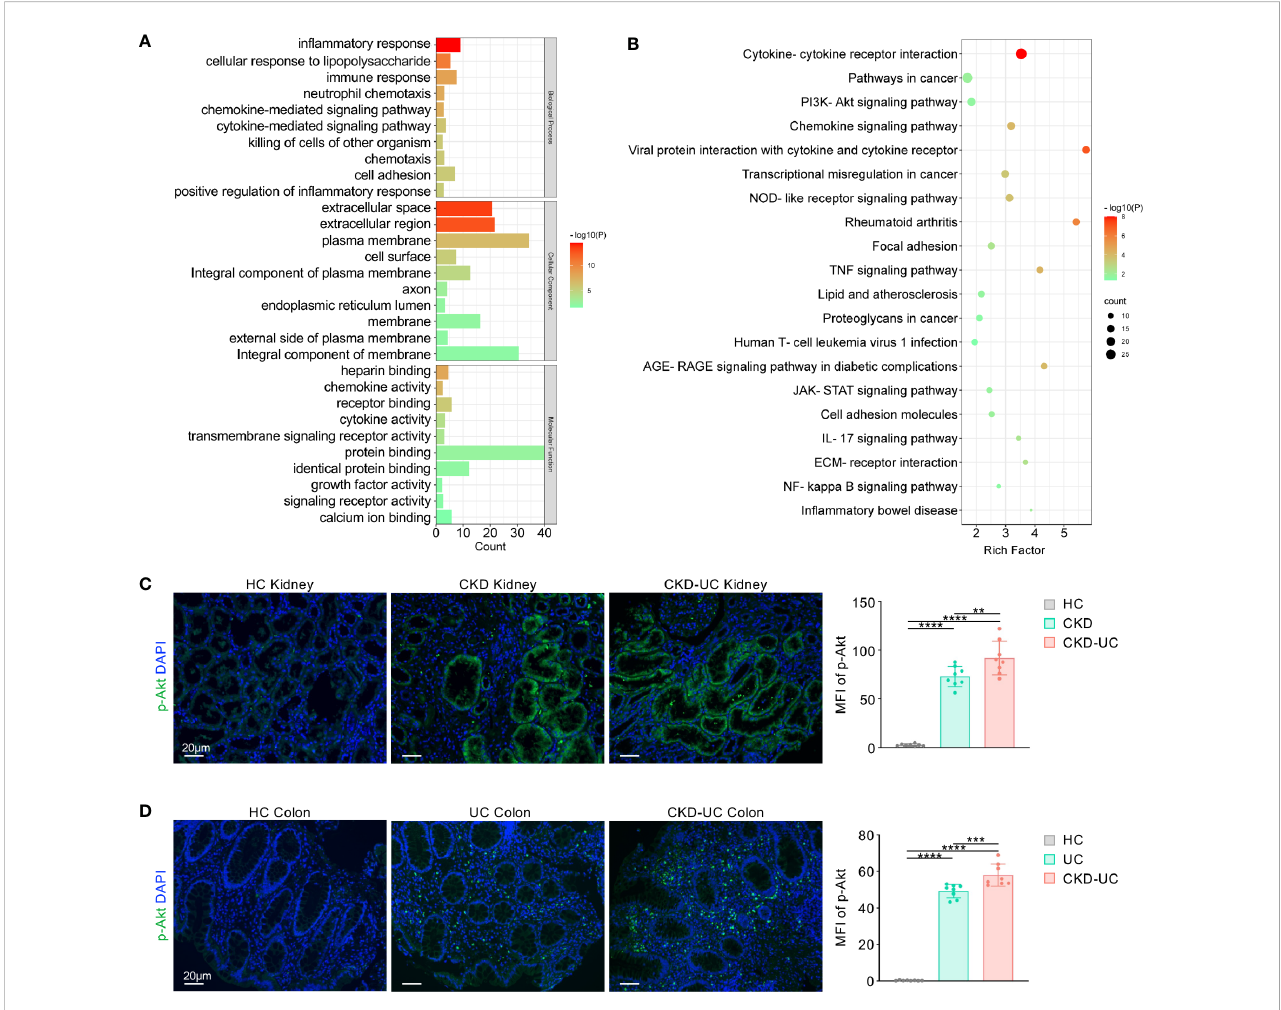
FIGURE 3 Functional enrichment analysis of common DEGs. (A) GO terms in biological process, cellular component, and molecular function were used for functional enrichment clustering analysis on common DEGs. (B) KEGG pathway analysis was performed on common DEGs. (C, D) Representative immuno fl uorescence staining images of p-Akt (green) of kidney (C) and colon (D) biopsies from HC, CKD, UC and CKD-UC patients. Cell nuclei were counterstained with DAPI (blue). Scale bars, 20 m m. The MFI of p-Akt was measured by Image (J) DEG, differentially expressed genes; GO, Gene Ontology; KEGG, Kyoto Encyclopedia of Genes and Genomes; HC, healthy control; CKD, chronic kidney disease; UC, ulcerative colitis; MPO, myeloperoxidase; MFI, mean fl uorescence intensity; p-Akt, phospho-Akt. Data in C and D were presented as mean ± SEM, ****P < 0.0001; ***P < 0.0005; **P < 0.005